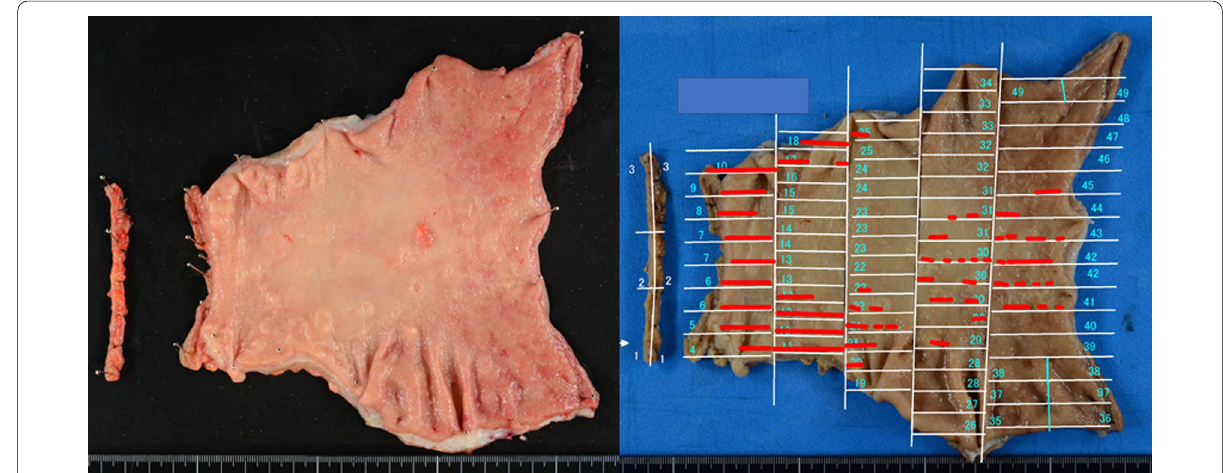
Fig. 4 Macroscopic findings in the resected stomach. Cancer cells were seen only at the range of the red lines with no involvement of the proximal or distal